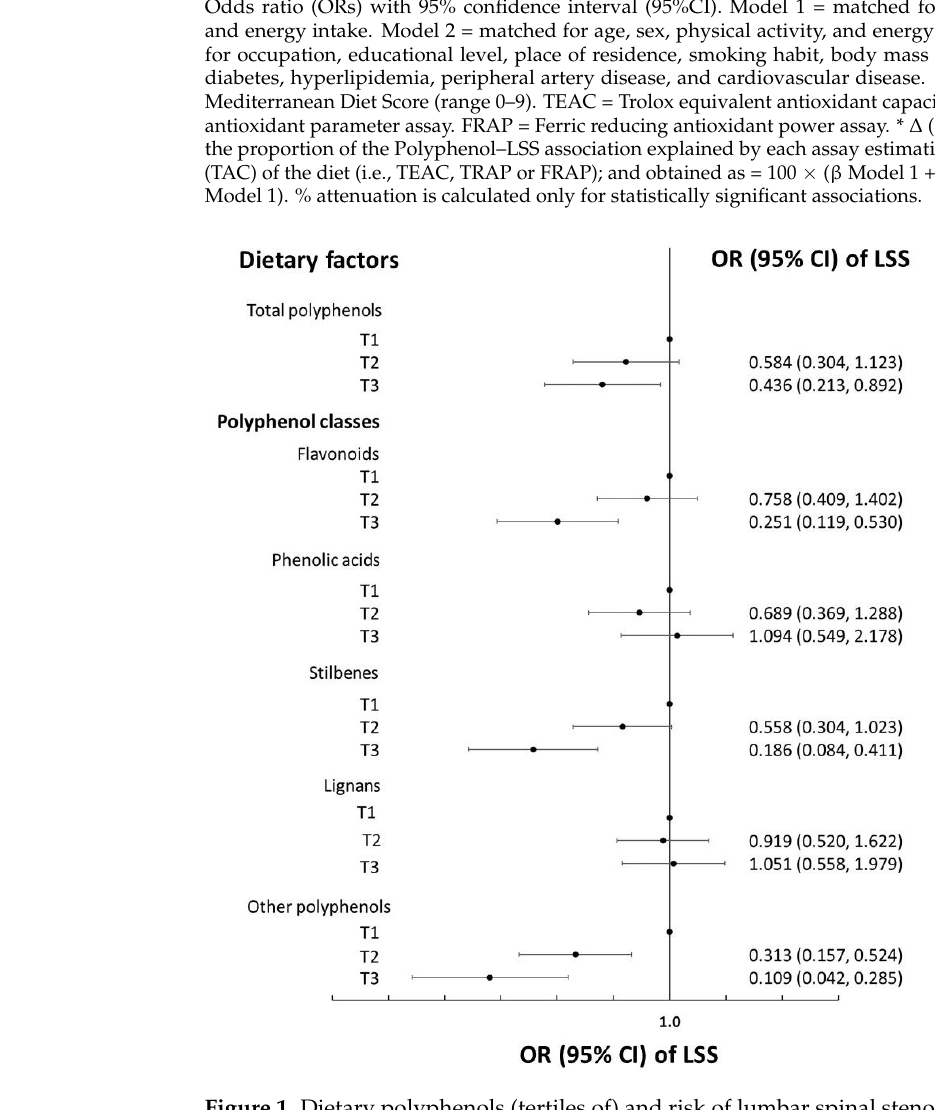
Figure 1. Dietary polyphenols (tertiles of) and risk of lumbar spinal stenosis (LSS) in the PREFACE case-control study. Odds ratios (ORs) and their 95% confidence intervals (CIs) were calculated using conditional-to-match (for age, sex, and physical activity) logistic regression adjusted for energy intake, occupation, educational level, smoking habit, place of residence, body mass index, cancer, hypertension, diabetes, hyperlipidemia, peripheral artery disease, cardiovascular disease, and the Mediterranean Diet Score. Table 4. Association of dietary polyphenols with risk of Lumbar Spinal Stenosis.